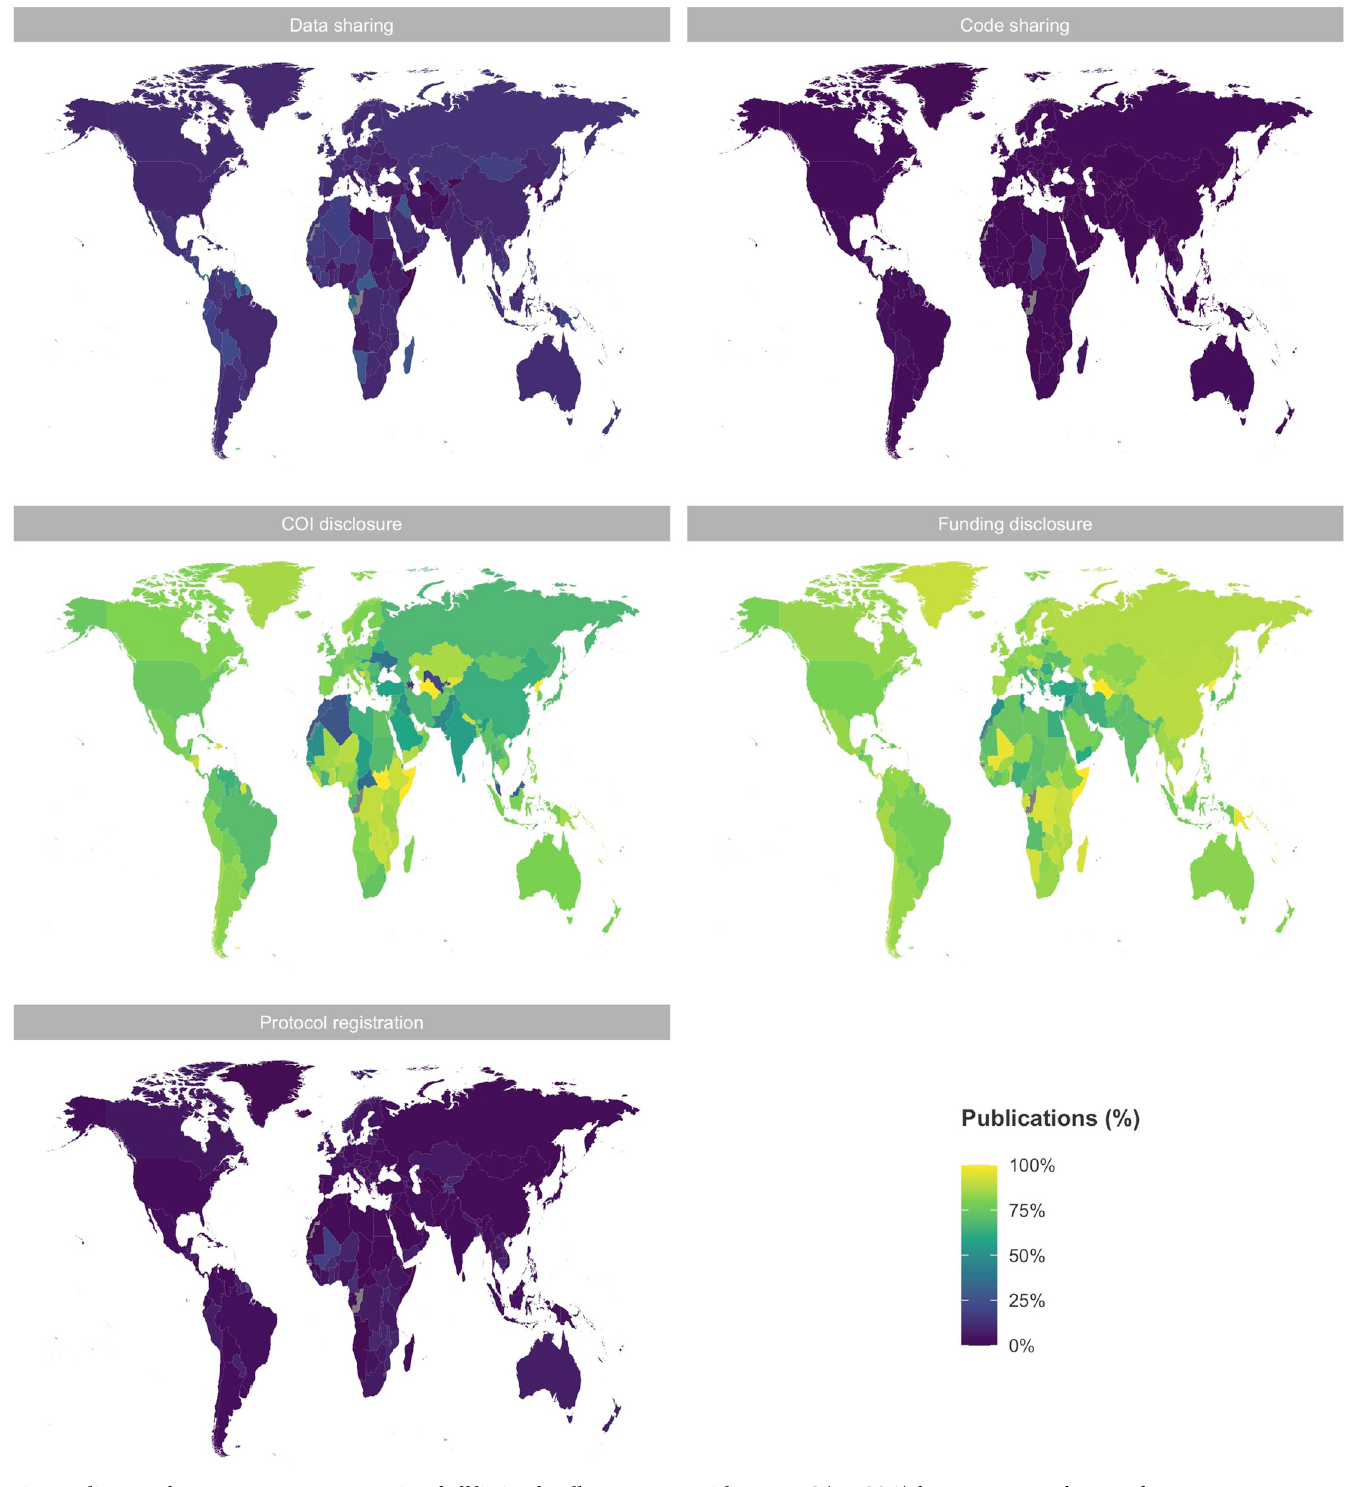
Fig 4. Indicators of transparency across countries of affiliation for all open access articles on PMC (PMCOA) for 1990–2020. Indicators of transparency are roughly homogeneously reported across countries. The light green to yellow maps indicate that the majority of publications from most countries reported COI and Funding disclosures. The purple maps indicate that the majority of publications from most countries did not report any Data, Code, or Protocol sharing. Note that the country was only reported in 479,843 articles. The data underlying this figure can be found on OSF at http://www.doi.org/10.17605/OSF.IO/E58WS. COI, Conflict of interest; OSF, Open Science Framework; PMC, PubMed Central; PMCOA, PubMed Central Open Access. https://doi.org/10.1371/journal.pbio.3001107.g004 PLOS Biology | https://doi.org/10.1371/journal.pbio.3001107 March 1,